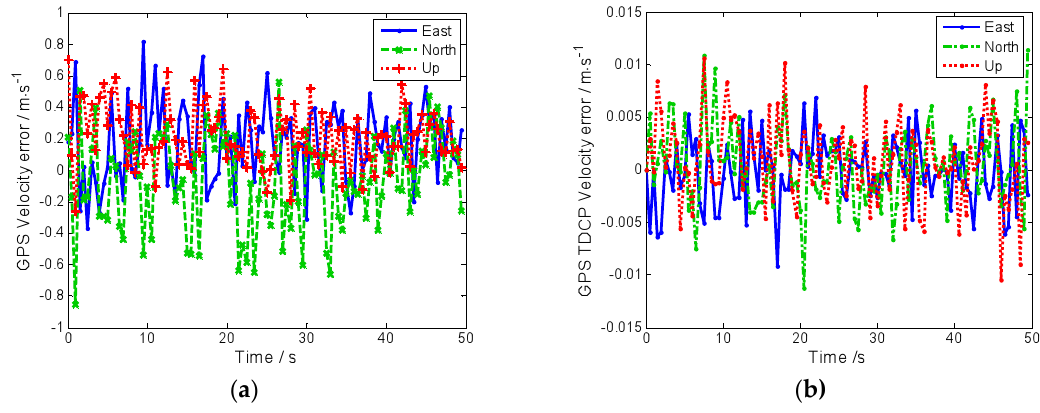
Figure 10. ( a ) GPS velocity measurement error. ( b ) GPS TDCP velocity measurement error.